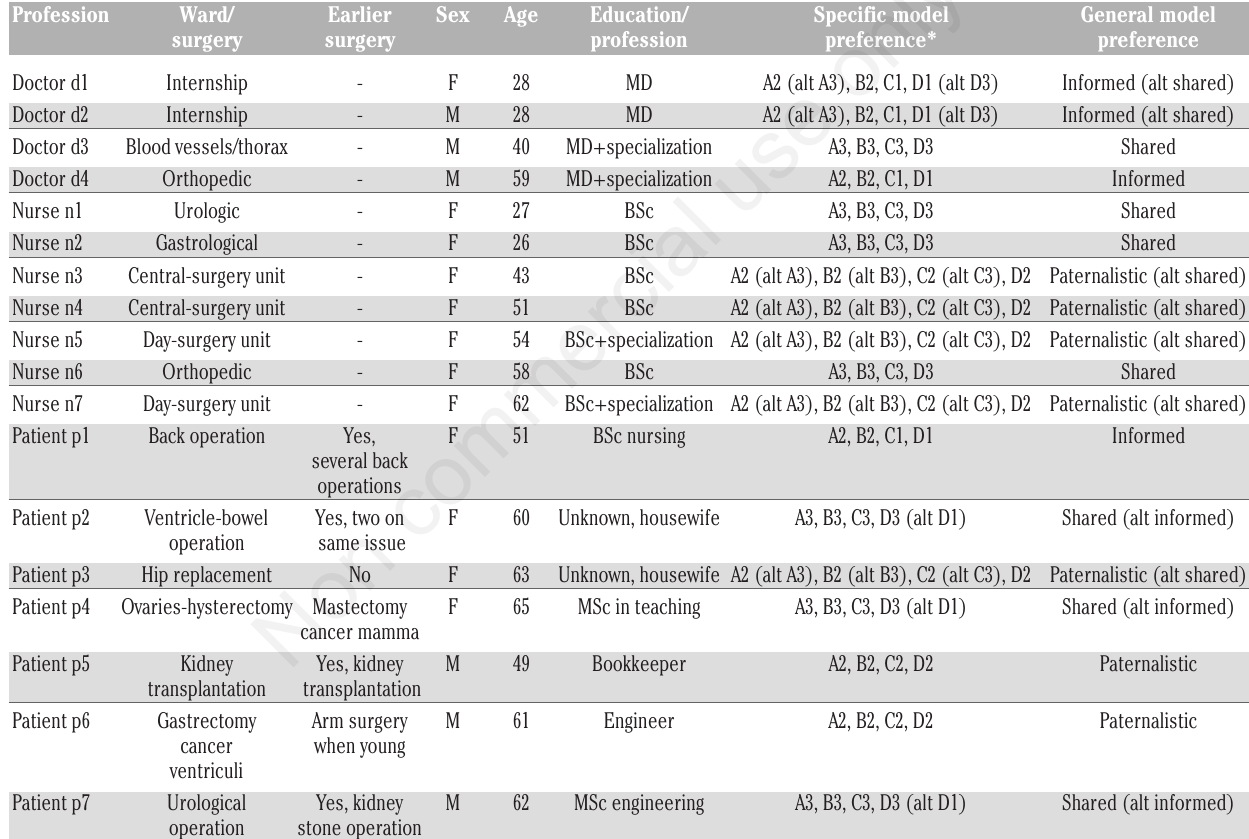
Table 1. Participants characteristics and model preferences.